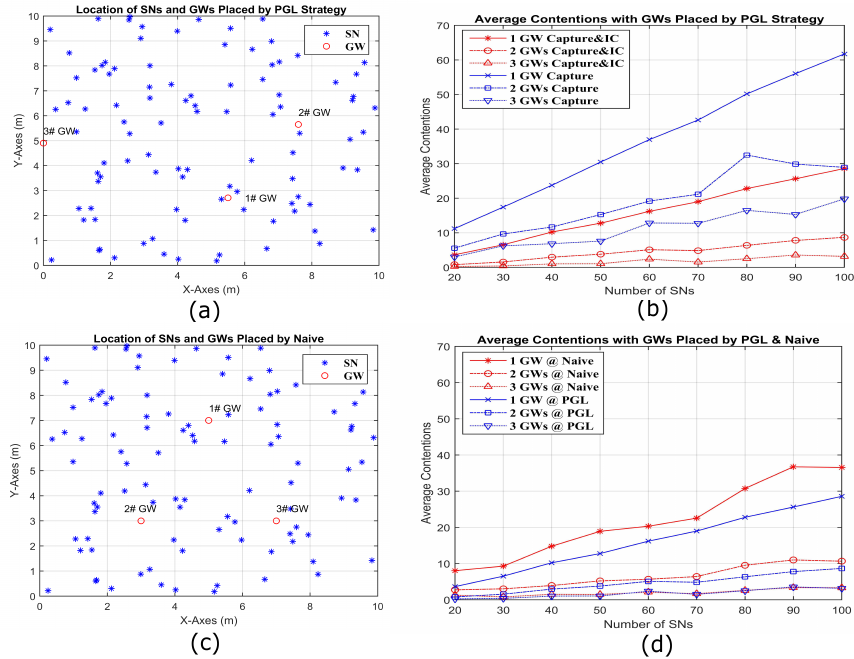
Figure 14. Simulation visualizations for three GWs placed by PGL ( a ) and by naive placement ( c ) in the circumference composed by 100 SNs in a uniformly random distribution. ( b ) The average contentions comparing in different number of GWs by capture and IC to capture only separately; and ( d ) the average contentions for capture and IC comparing in different number of GWs placed by PGL and